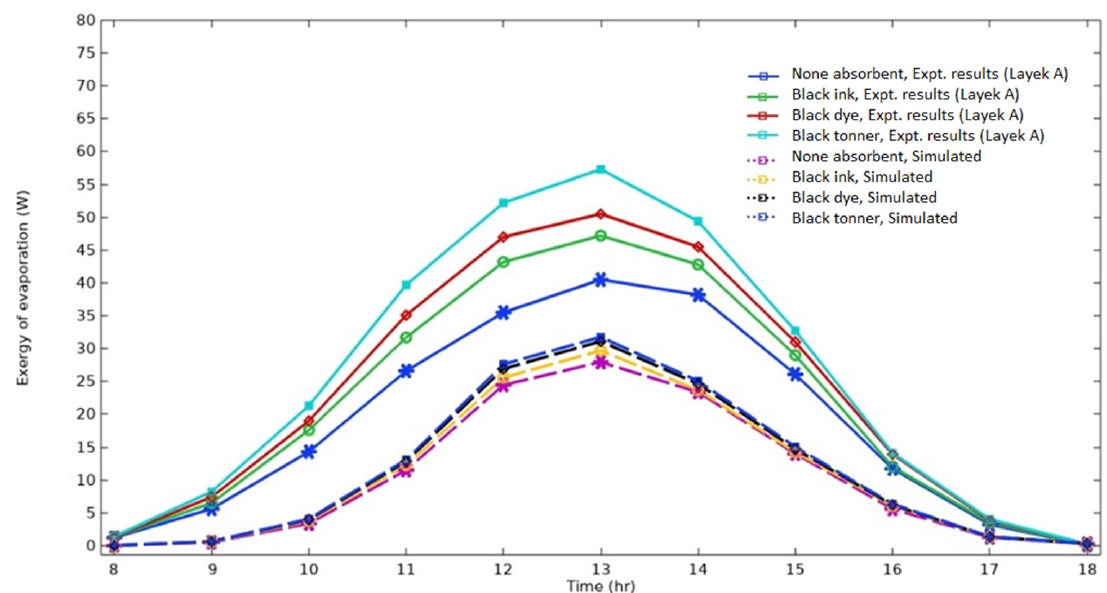
Figure 8. Exergy of evaporation of the solar still for different absorbers in water.